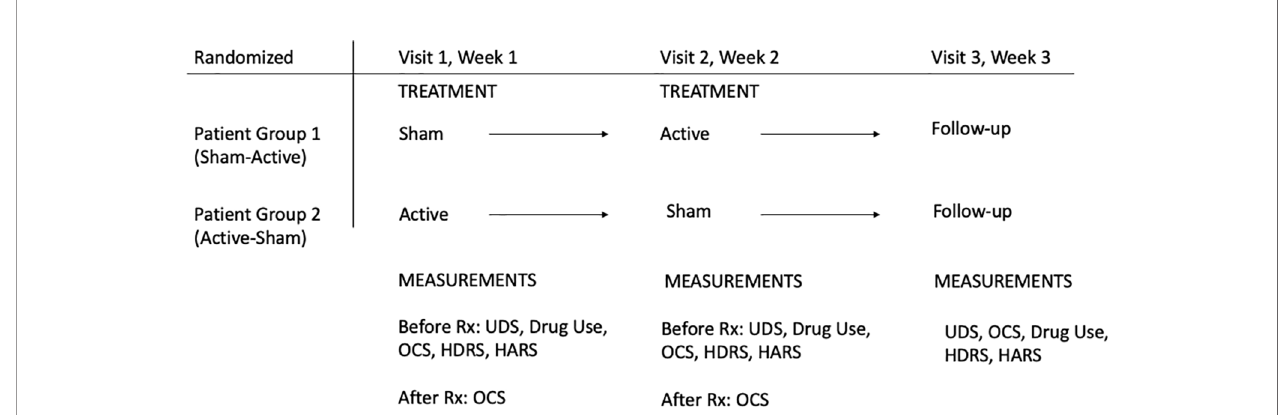
FIGURE 2 | A diagram of the randomization and timing of the study treatments and